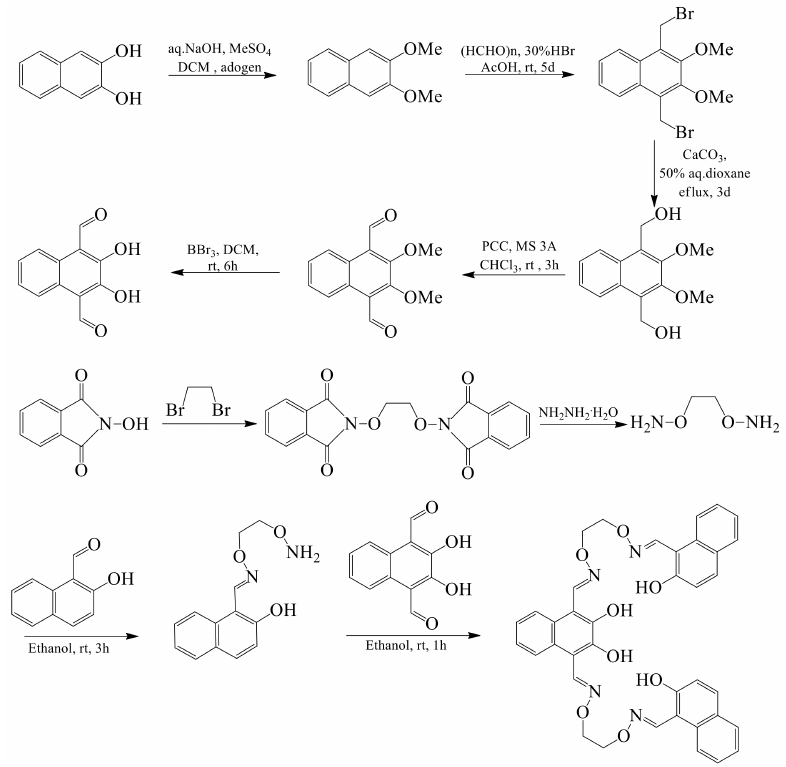
Scheme 1. Synthetic route to sensor H 4